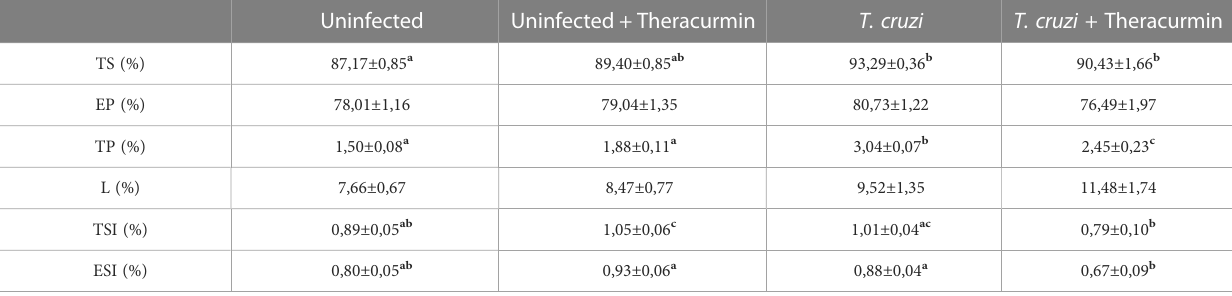
TABLE 2 Parameters of the tubules seminiferous of Swiss mice infected with T. cruzi and treated with Theracurmin.